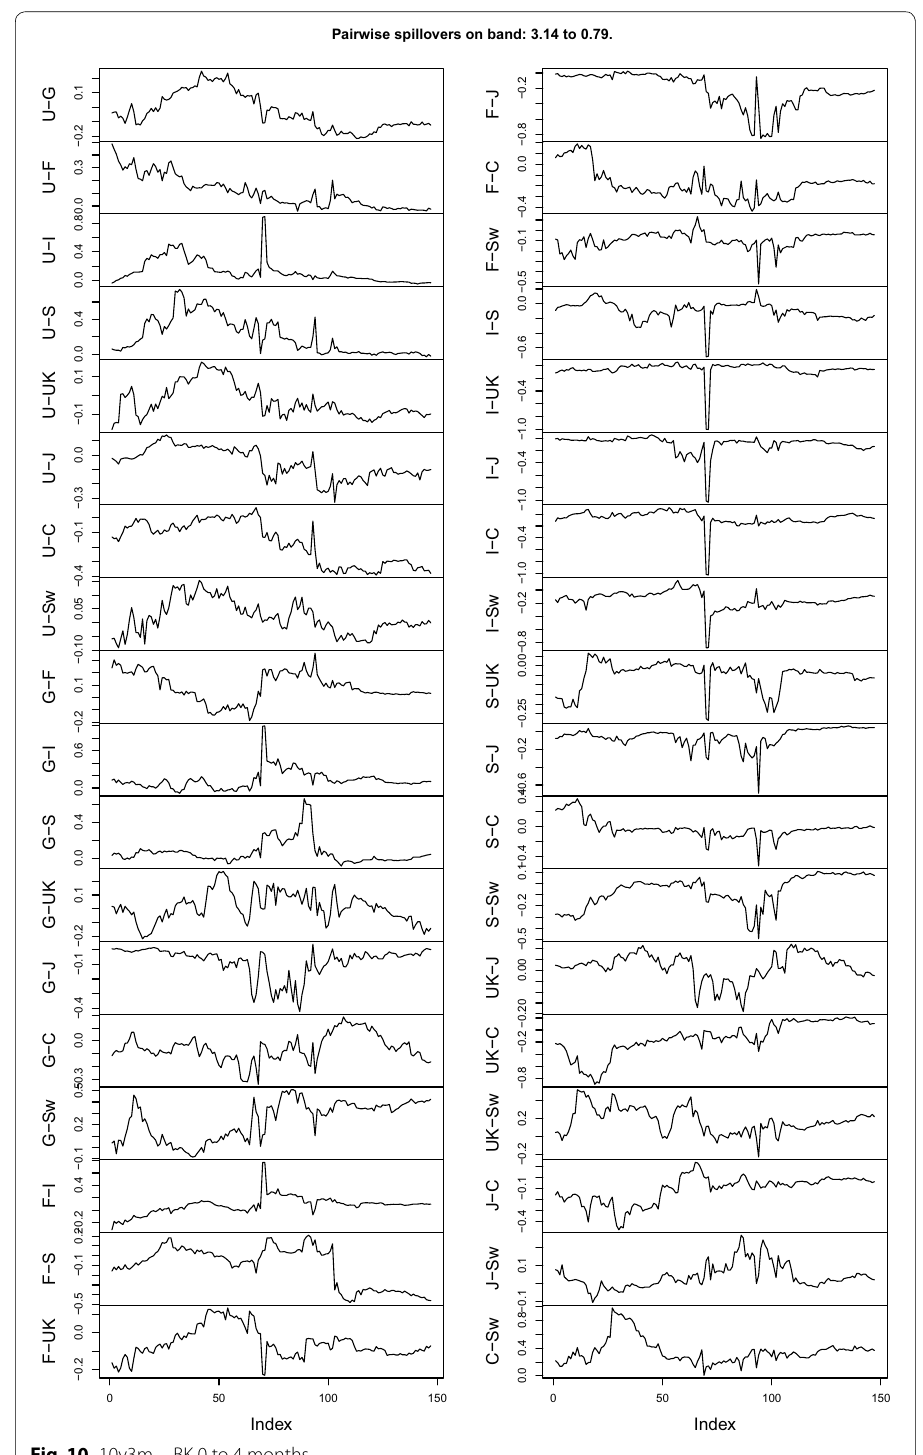
Fig. 10 10y3m—BK 0 to 4